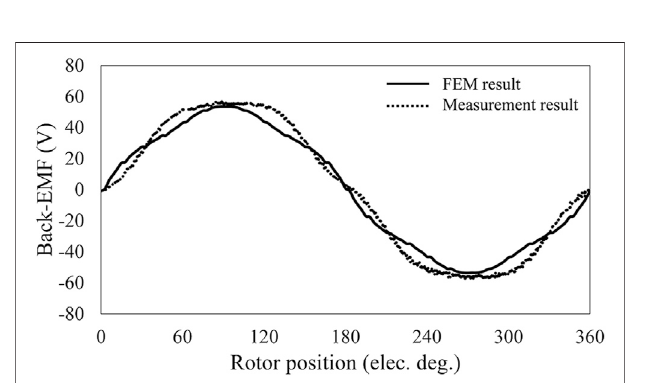
FIGURE 10 | The 2-D FEM and measured phase back-EMF of the proposed 18/15-poles DSPM.